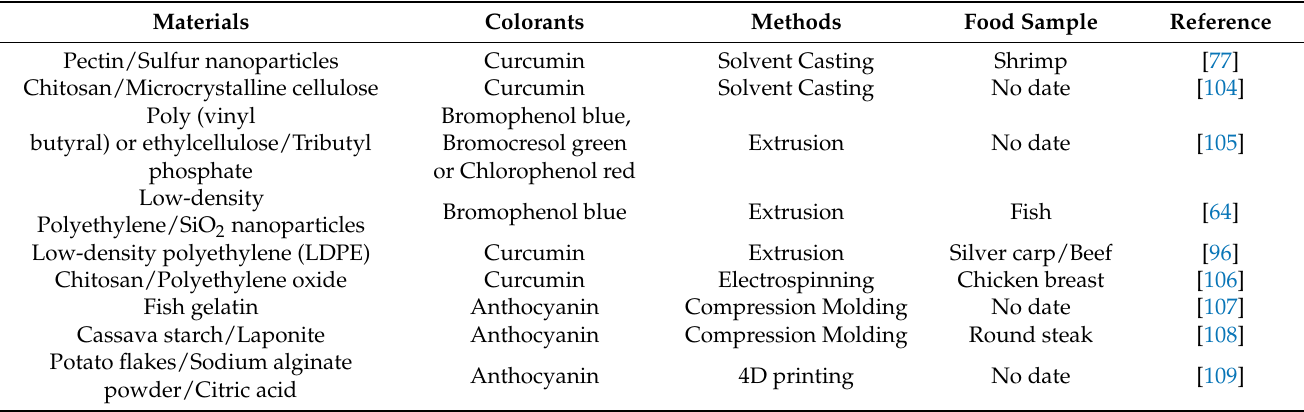
Table 1. Methods of developing pH-responsive freshness indicators.